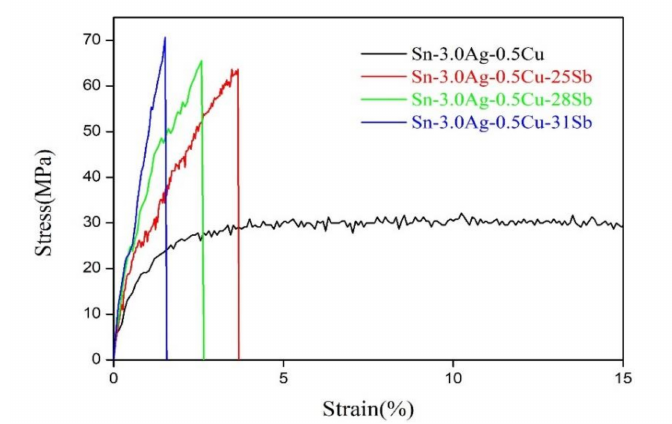
Figure 7. Stress–strain curves of Sn-3.0Ag-0.5Cu- x Sb solder alloy.